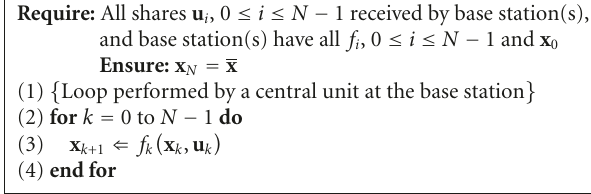
Algorithm 2: Decryption at base station(s) for